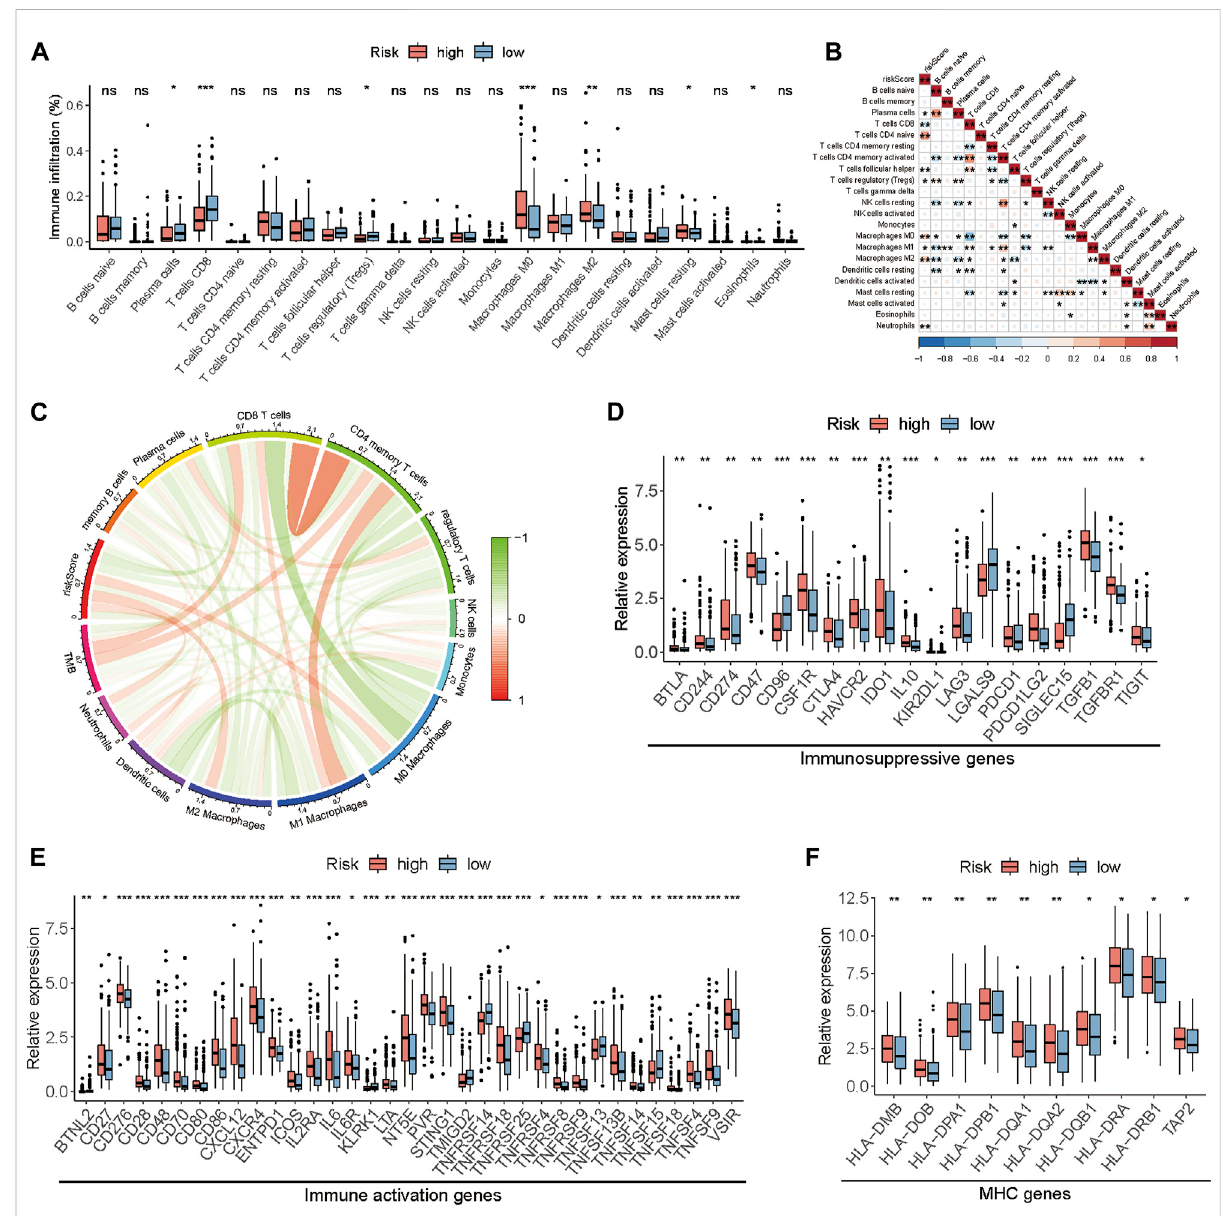
FIGURE 6 The relationship between the risk score and the TME in TCGA-BLCA cohort. (A) The fraction of tumor-in fi ltrating immune cells between the highandlow-riskgroups. (B) Thecorrelationanalysisbetweenriskscoreandtumor-in fi ltratingimmunecells. (C) Thecorrelationanalysisamongrisk score, immune cells, and TMB. (D – F) The differences in the expression of immunoregulatory genes. (* p < 0.05, ** p < 0.01, *** p <